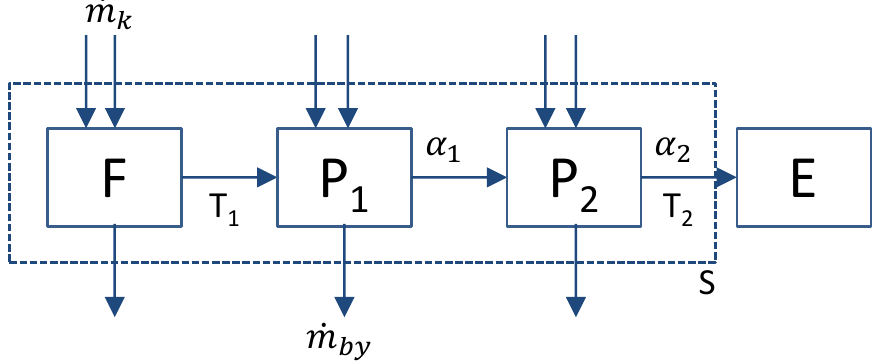
Figure 1. System boundaries of the well-to-tank (WTT) assessment from feedstock cultivation to the tank for each pathway, shown by the dashed line S. The resulting abatement is compared on the basis of different functional units, such as GHG abatement per energy unit, cost per GHG abatement and GHG abatement per land area used. F = feedstock cultivation; T = transport; P 1 = Process 1; P 2 = Process 2; E = end use; ˙ m k = process inputs; ˙ m by = process byproducts; α = allocation factor. The end use, as well as potential indirect land use effects are not included. The biofuel combustion is assumed to be carbon neutral, as the carbon absorbed during plant growth is emitted, thus closing the